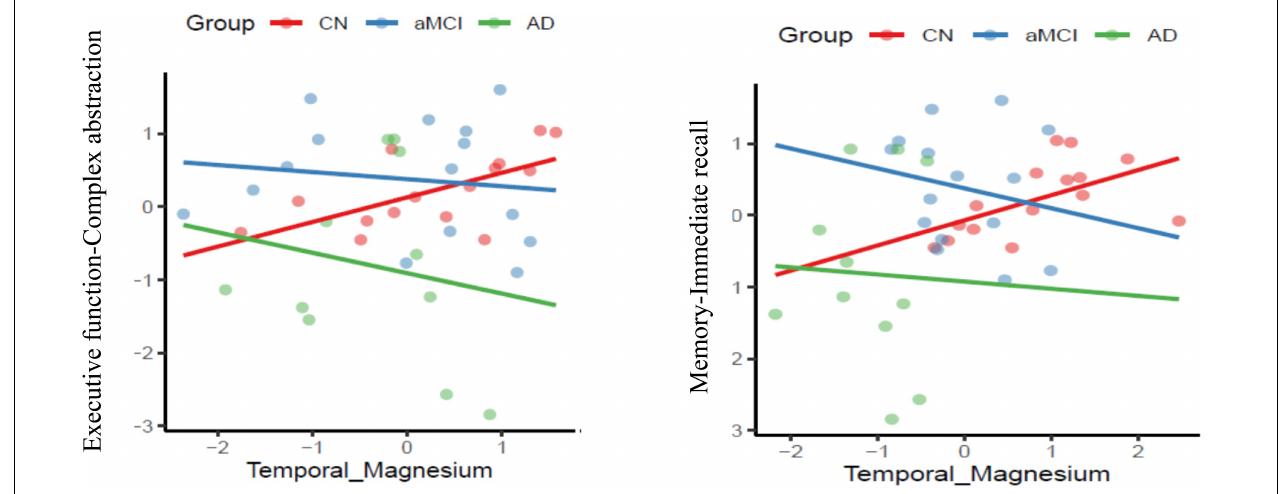
FIGURE 4 | Association of co-factor magnesium (Mg 2 + ) in the temporal brain region with cognitive performance domains of executive function and memory respectively across the three groups-cognitively normal (CN-red color), amnestic mild cognitive impairment (aMCI-blue color) and mild Alzheimer’s diseases (AD-green color) ( p ≤